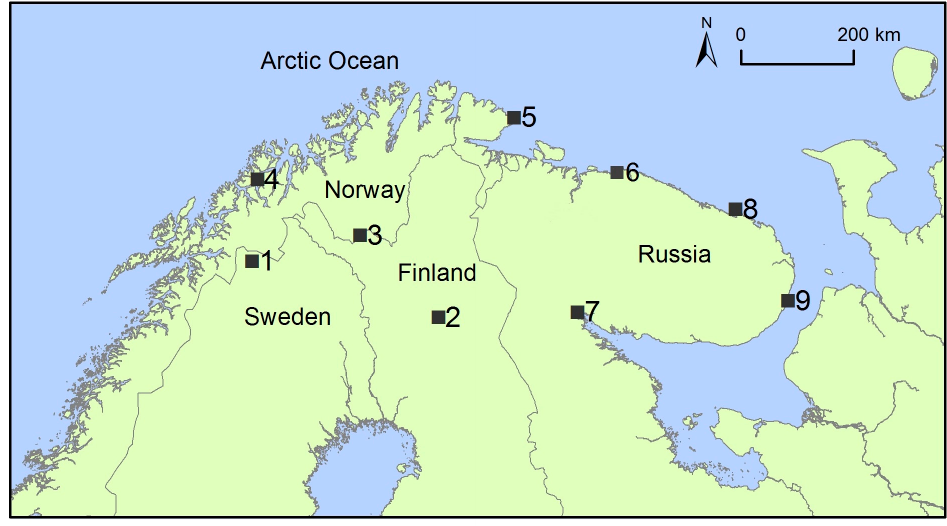
Figure 1. The location of weather stations in northern Fennoscandia. (1) Abisko, (2) Sodankylä, (3) Sihccajavri, (4) Tromsø, (5) Vardø, (6) Teriberka, (7) Kandalaksa, (8) Svyatoy Nos, (9) Ostrov Sosnovez. Table 1. Weather stations included in the study and their general climate characteristics. Annual mean temperature (Tmean), January mean temperature (TJan), July mean temperature (TJul) and annual precipitation sum (Prec) were calculated for the period 1914–2013.